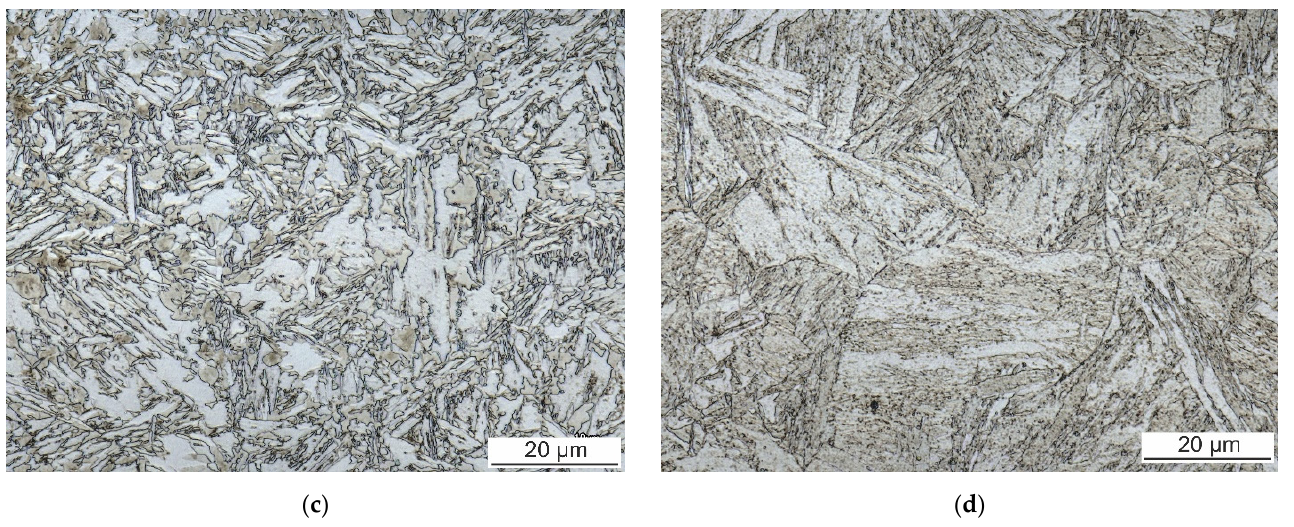
Figure 10. Subzones of HAZ of hybrid weld made with 20 A: ( a ) CGHAZ, ( b ) FGHAZ, ( c ) ICHAZ, and ( d ) SCHAZ.